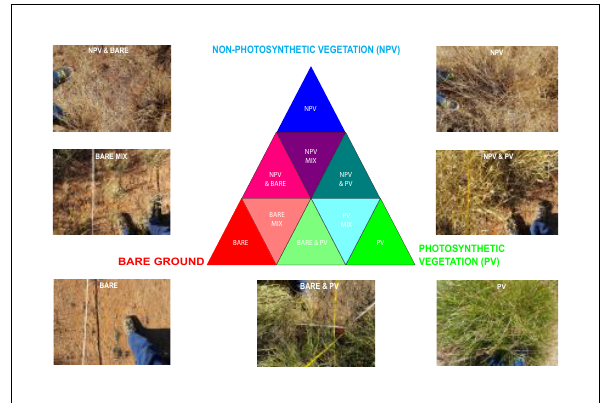
Figure 3. Field photographs of fractional ground cover components and their corresponding colour triangle representation.